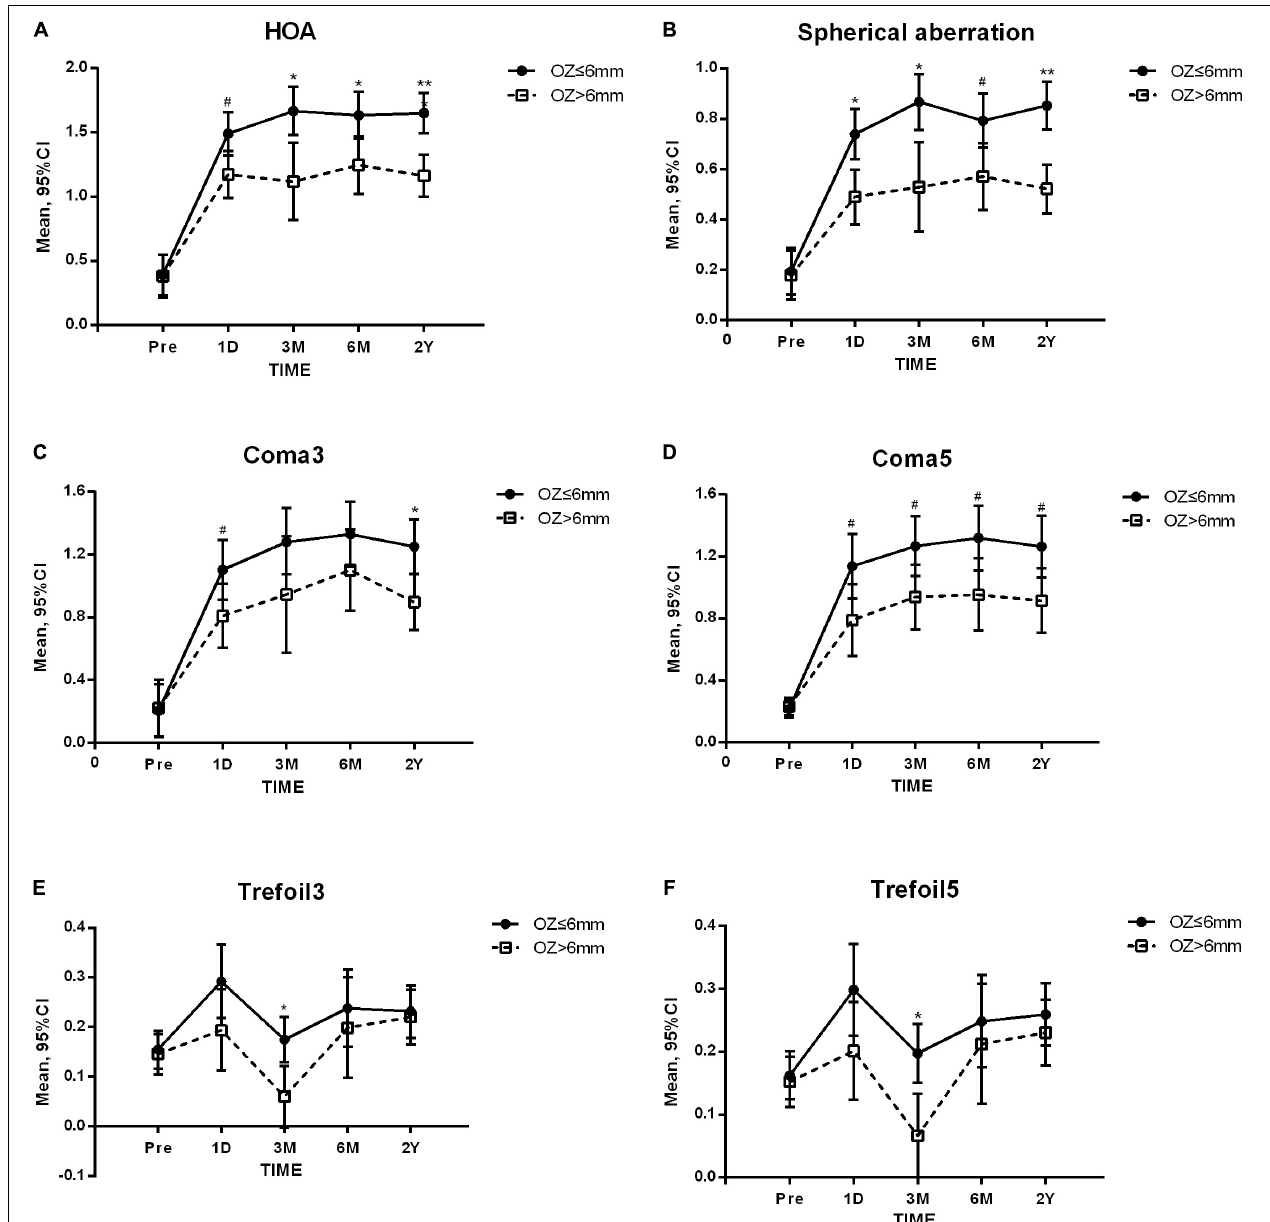
FIGURE 3 | Higher-order aberrations before and after small incision lenticule extraction (SMILE). OZ, optical zone. Compared between OZ groups: ** p < 0.001 * p < 0.01 # p < 0.05, (A) Total higher-order aberration (HOA). (B) Spherical aberration. (C) 3rd order coma (Coma3). (D) 3rd and 5th order coma (Coma5). (E) 3rd trefoil (Trefoil3). (F) 3rd and 5th order trefoil